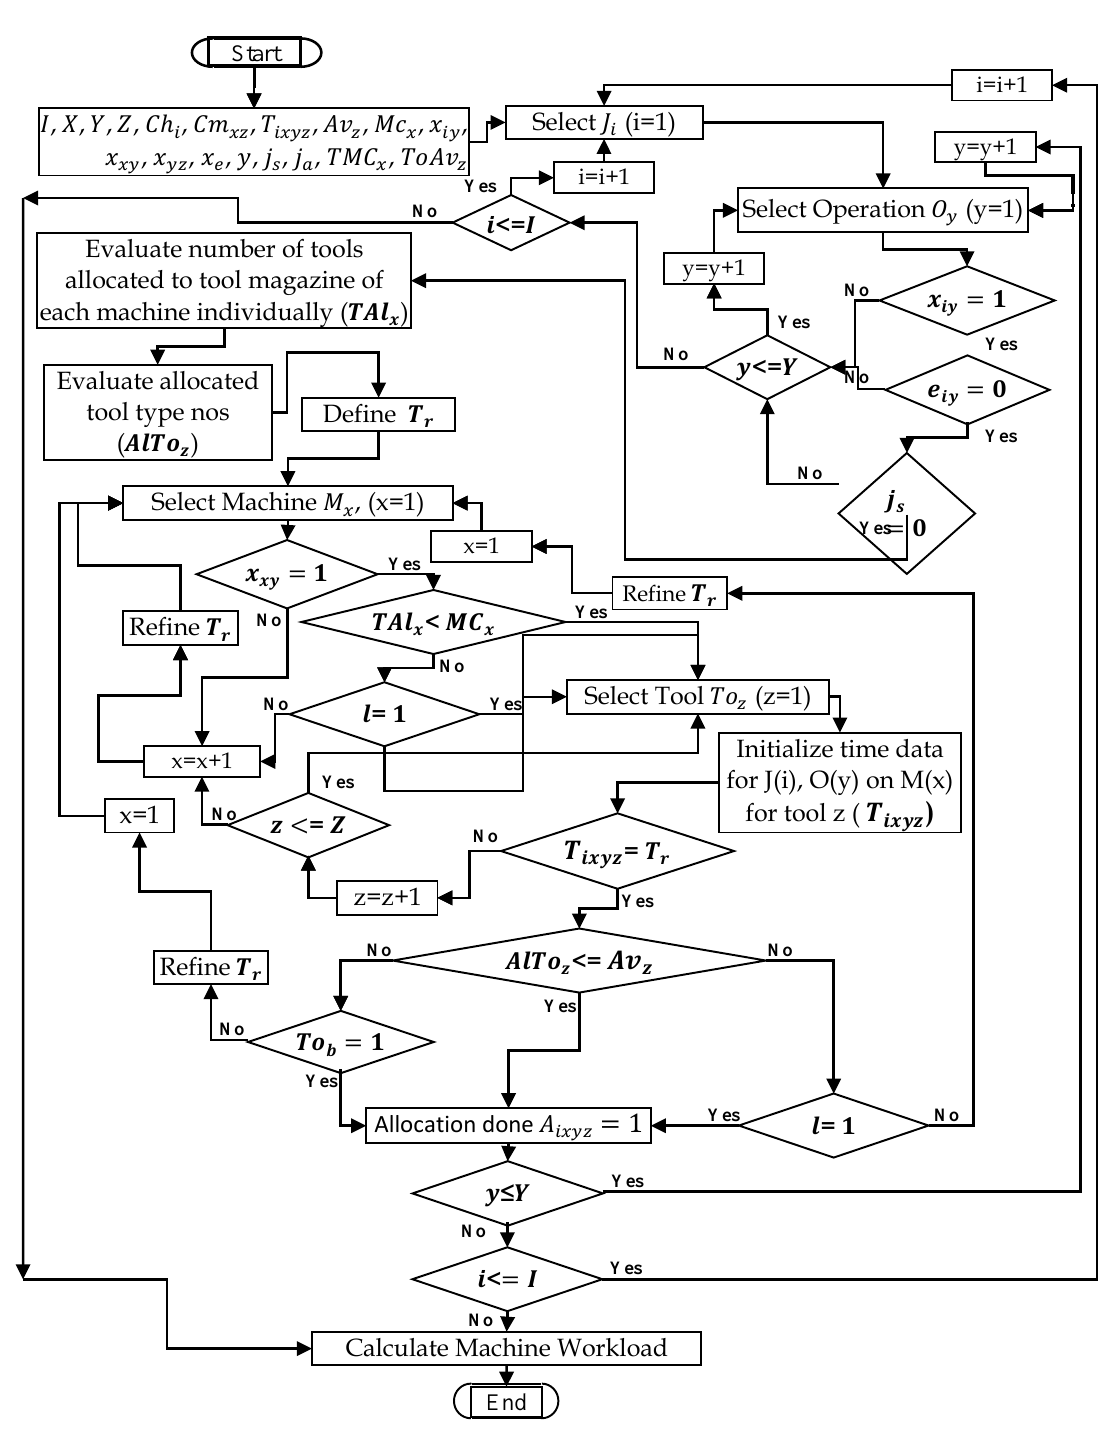
Fig. 2. Developed intelligent algorithm LOMFNEO for allocation of machines and tools for non-essential operations in general